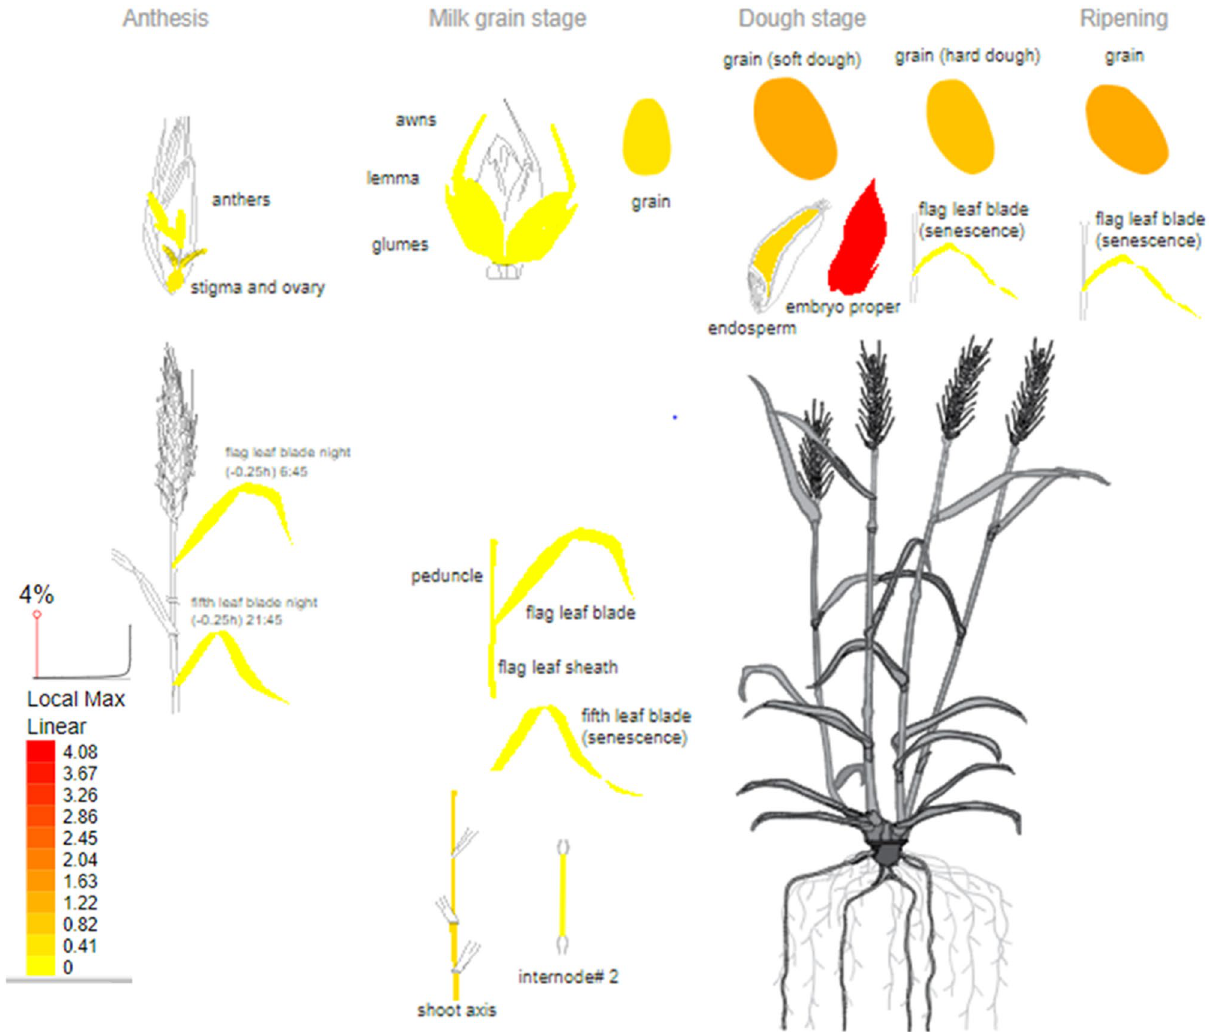
Figure 4. Expression profile of TraesCS2D01G331100 gene based on transcriptomic analysis in wheat. As shown, this gene is most highly expressed in the developing embryo during embryogenesis and grain development in wheat. Data for this view derived from RNA-seq of wheat 48 and the image was generated with the eFP (RNA-Seq data) at http:// bar. utoro nto. ca/ eplant/ by Waese et al. 51 . The legend at bottom left presents the expression levels, coded by colors (yellow = low, red =